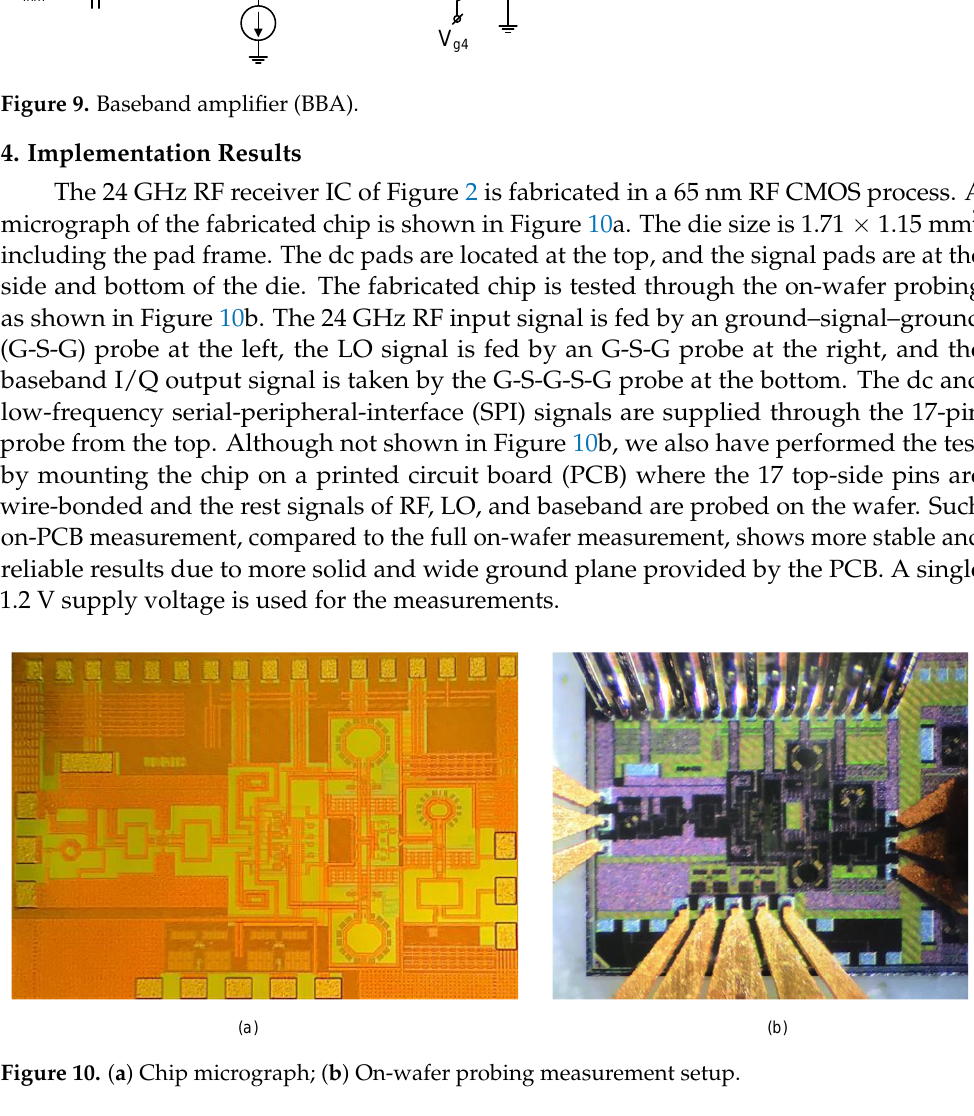
Figure 11. Frequency response characteristics. ( a ) Gain versus RF frequency; ( b ) Gain versus baseband frequency. Figure 12a shows the measured and simulated noise figure. For the noise figure measurement, the total output noise power P n,out is first measured by using a spectrum